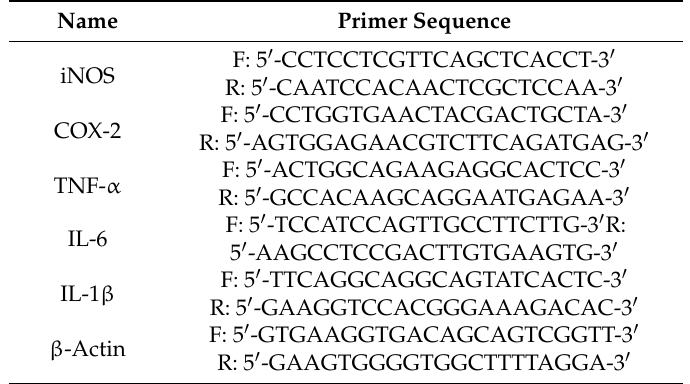
Table 1. Primers used for the reverse transcription polymerase chain